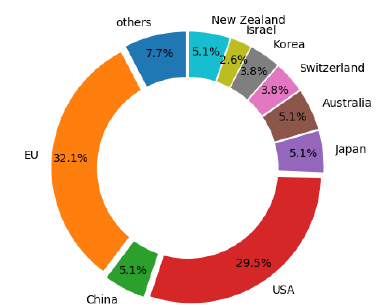
Figure 10. Publications by countries in R&D.